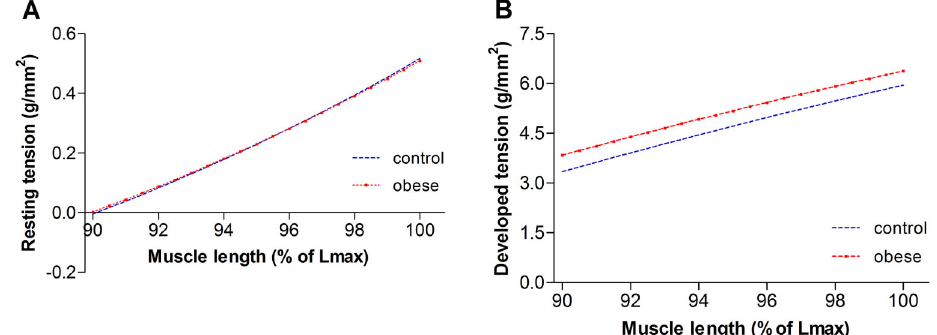
Figure 2. The relationship between muscle length and ( A ) resting tension and ( B ) developed tension from control (n=11) and obese (n=11) rats, using the progression model adjusted according to the group.